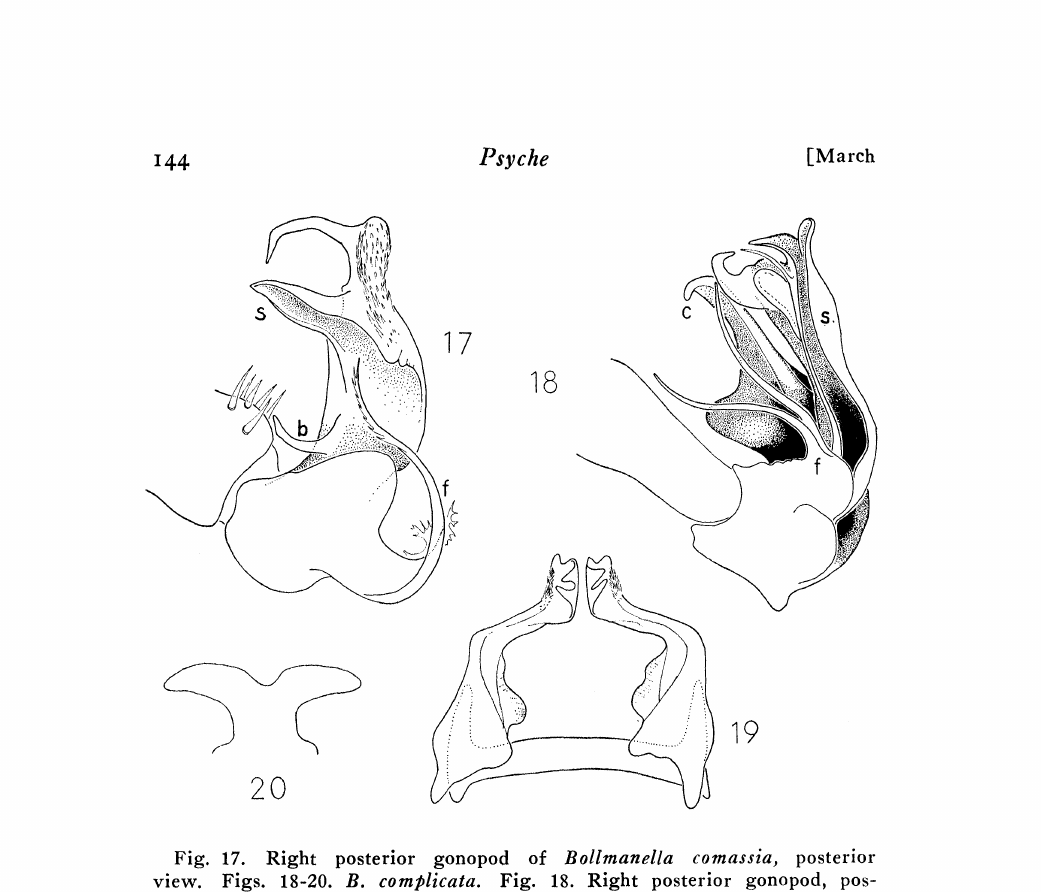
Fig. 17. Right posterior gonopod of Bollmanella comassia, posterior view. Figs. 18-20. B. comllicata. Fig. 18. Right posterior gonopod, pos- terior view. Fig. 19. Anterior gonopods, posterior view. Fig. 20. Sternal process between posterior